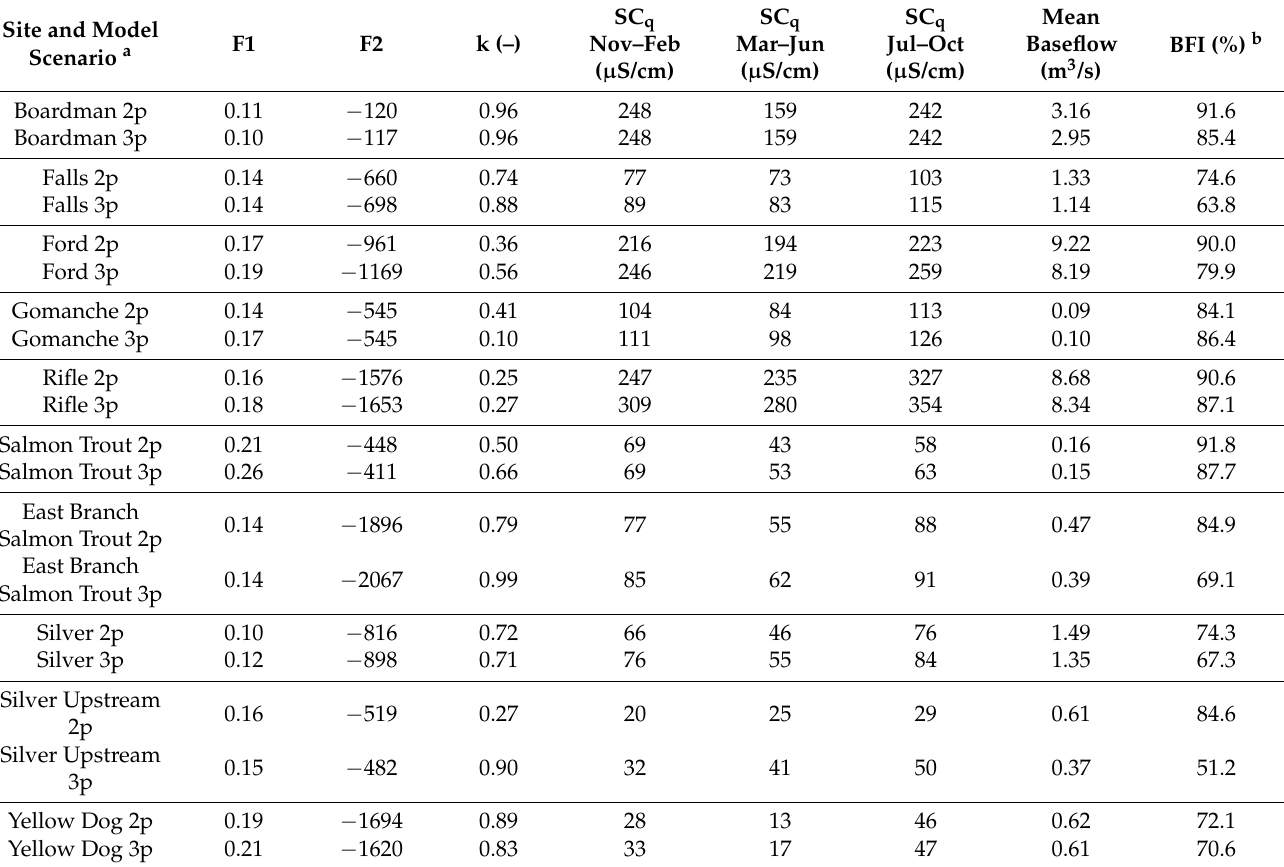
Table 2. MOO results for trade-off